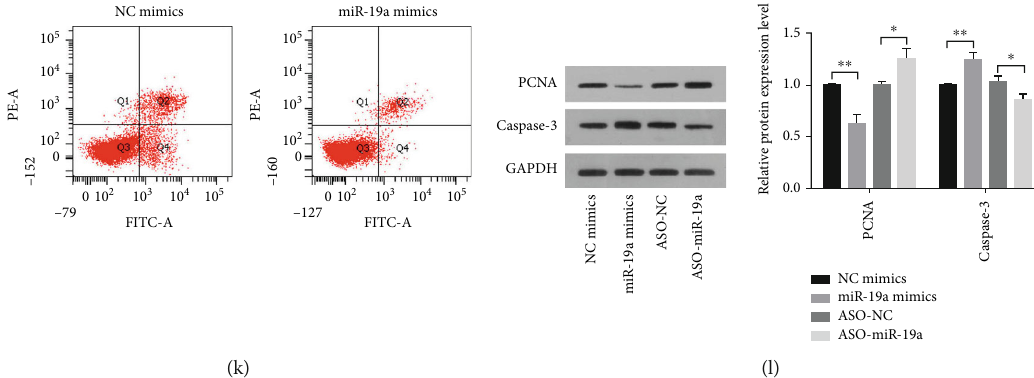
Figure 4: E ff ects of miR-19a on oxidative stress and proliferation of tenocytes. (a – d) qRT-PCR was used to detect the expression of miR-19a in EVs. (a, b) Detect EVs obtained by high-speed di ff erential centrifugation. (c, d) Detect EVs obtained by Exosome Puri fi cation Kit. (e) qRT-PCR was used to detect the expression of miR-19a in exosomes secreted from tendon tissues. (f – i) ELISA was used to detect the levels of CK, LDH, MDA, and SOD both in the NC mimic group, miR-19a mimic group, ASO-NC group, and ASO-miR-19a group. (j) MTT was used to detect the activity of tenocytes. (k) FCM was performed to detect the apoptosis of tenocytes. (l) The expression of apoptosis-related proteins was detected by Western blot in the NC mimic group, miR-19a mimic group, ASO-NC group, and ASO-miR- 19a group ( ∗ P < 0 : 05 , ∗∗ P < 0 : 01 , and ∗∗∗ P < 0 : 001